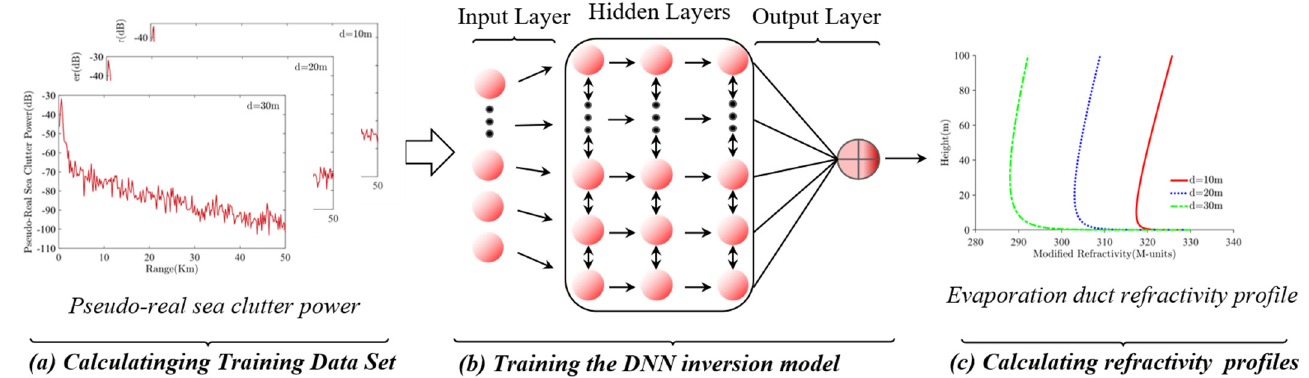
Figure 5. DNN − based EDH inversion model.